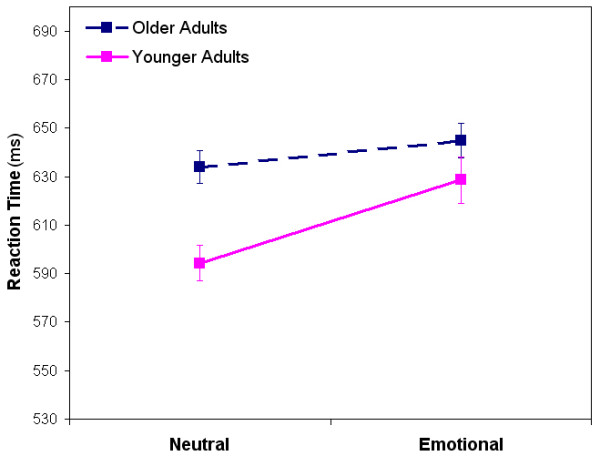
Reaction times for older and younger adults on mixed blocks. Younger adults were significantly slower on segments of the mixed blocks involving emotional words than those involving neutral category words. Older adults showed only a trend for similar slowing. Overall mixed group reaction times were not significantly different.